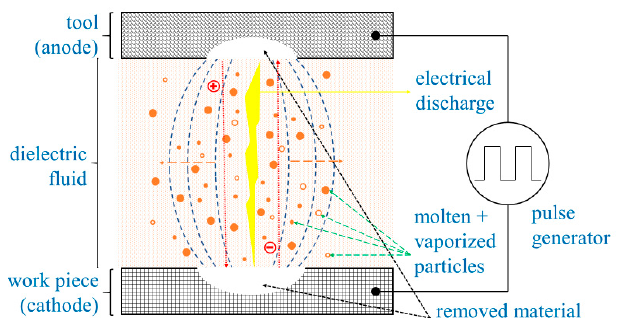
Figure 1. Scheme of electrical discharge mechanism used in EDM. The dotted blue lines represent the phases of the discharge—ionization, ignition, discharge, collapse—red lines the electron and proton migration forming the discharge channel and orange lines the direction of material removal stream.